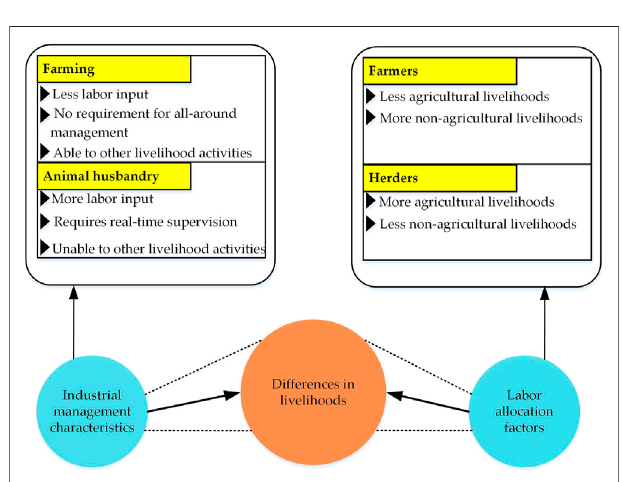
FIGURE 7| Driving factors of the differences in the livelihoodsof farmers and